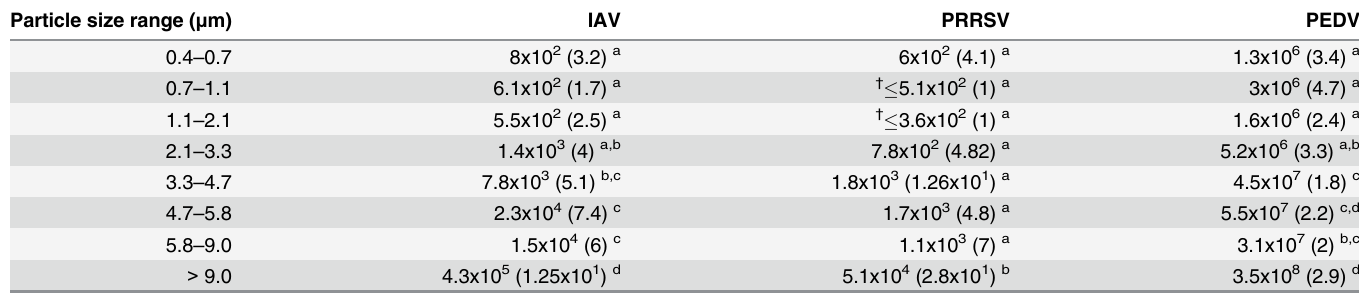
Table 1. Distribution by particle size of the quantity [geometric mean of RNA copies/m 3 (geometric standard deviation)] of influenza (IAV), porcine reproductive and respiratory syndrome (PRRSV) and porcine epidemic diarrhea (PEDV) viruses in air